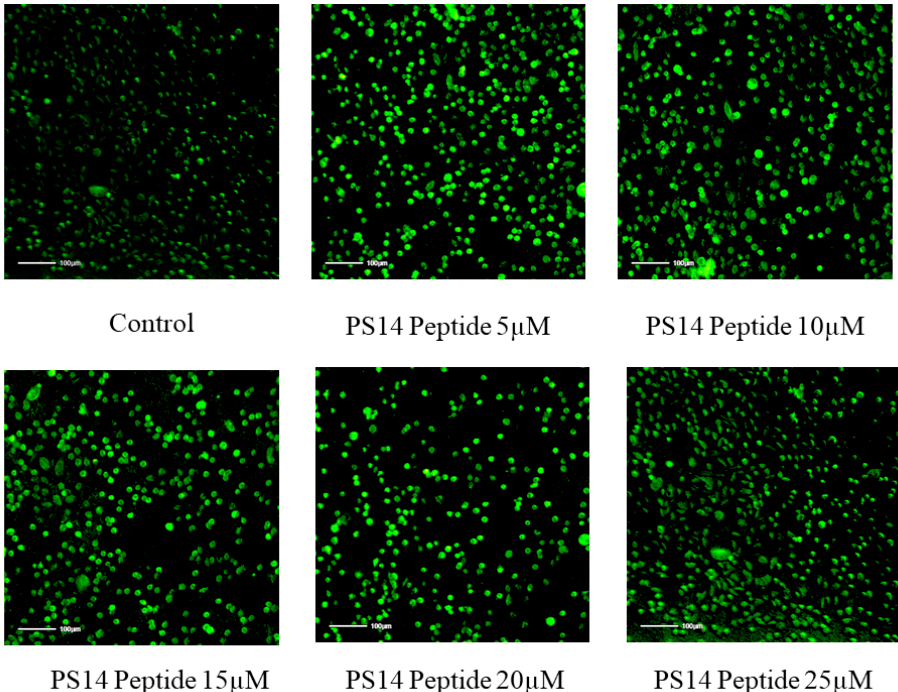
Figure 6. Measurement of the ability of PS14 intracellular ROS generation against Hep-2 cells. The ROS level was compared with the control (untreated) group.